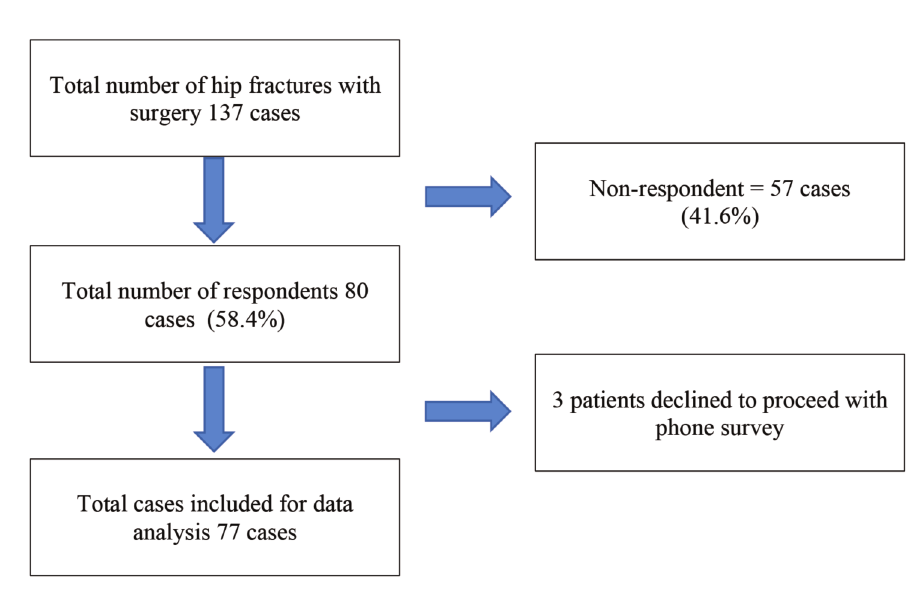
The recruitment flow and number of respondents. Fig. 1: